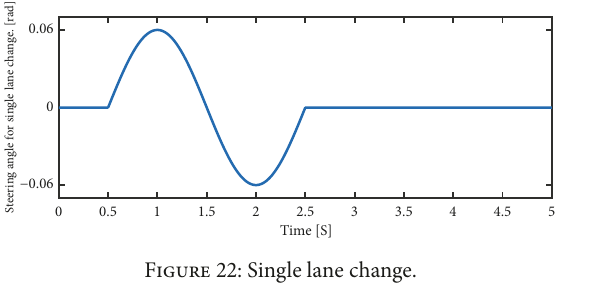
Figure 22: Single lane change.